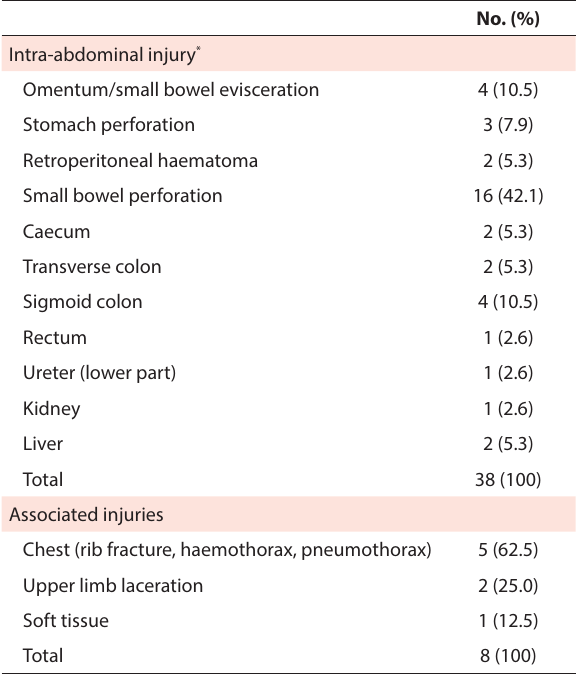
Table 2. Intra-abdominal and associated injuries